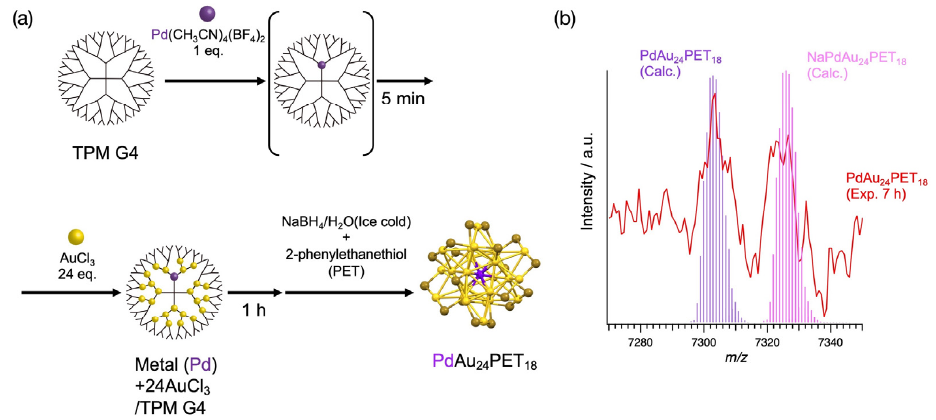
Figure 4. ( a ) Synthetic scheme of thiol-protected Au clusters blended with different elements (Pd) and ( b ) MALDI-TOF-MS spectrum of PdAu 24 PET 18 .